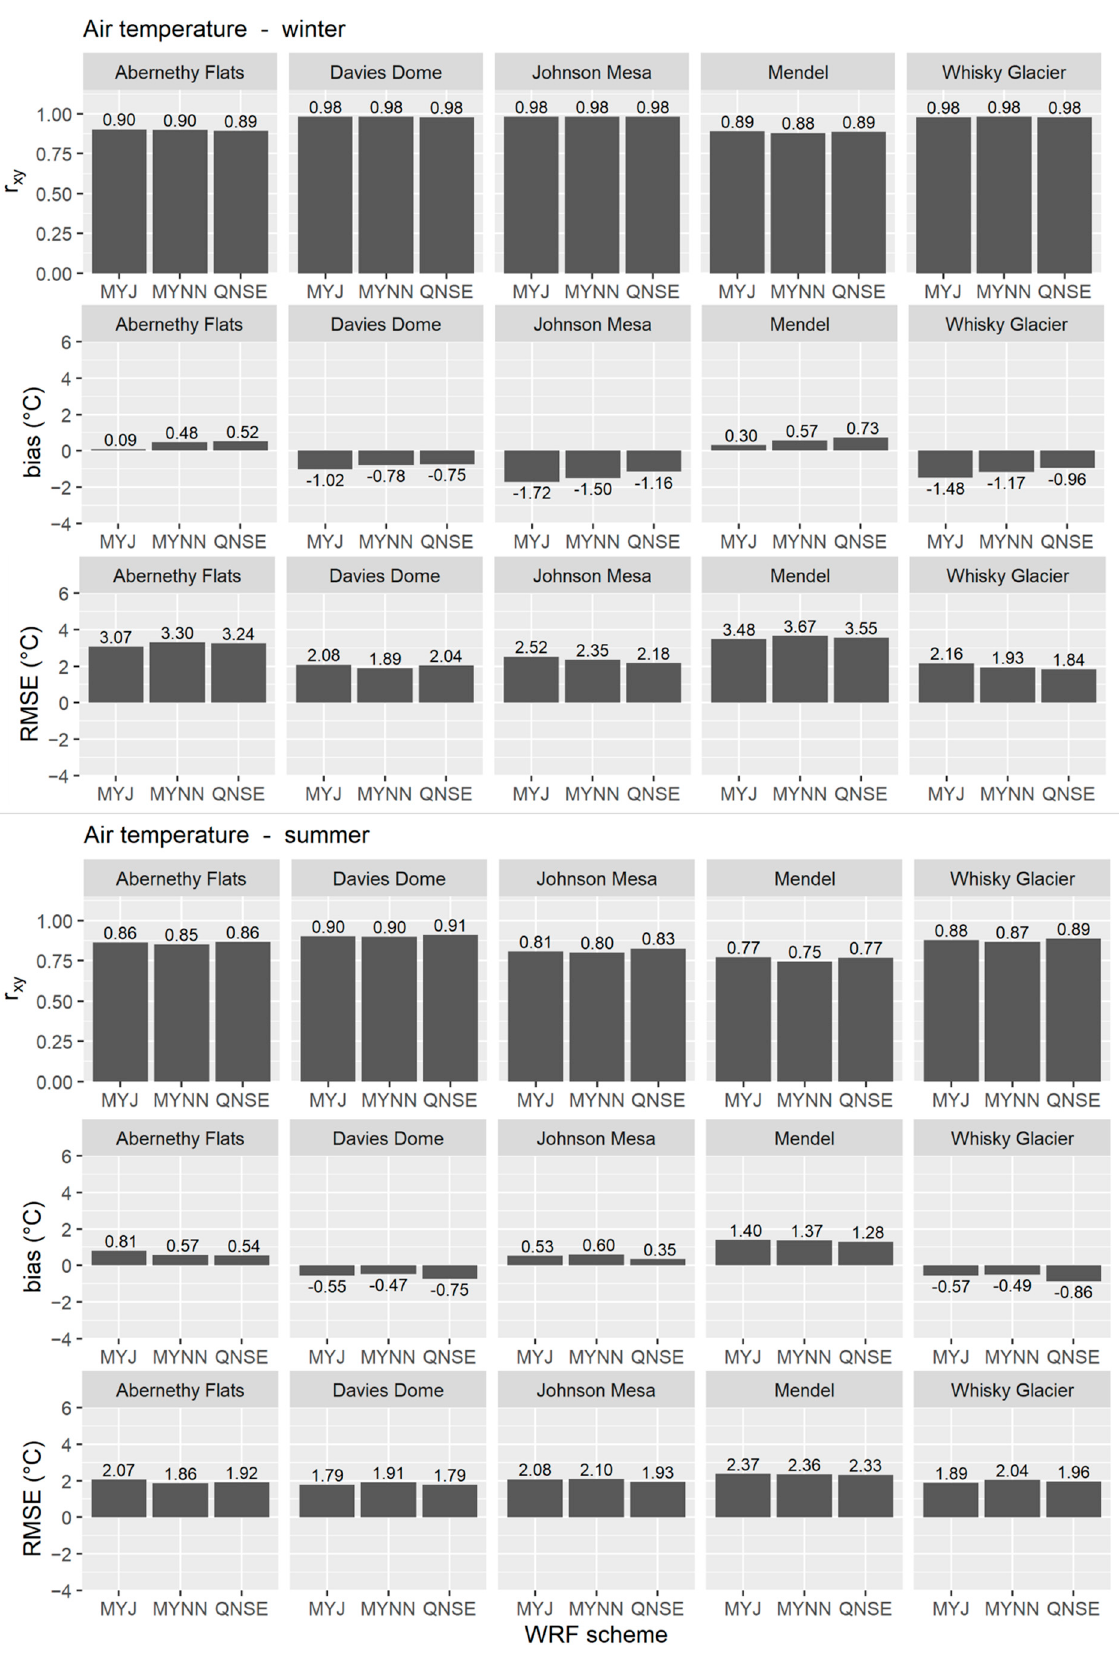
Figure 4. Validation statistics for modelled air temperature at selected automatic weather stations using three boundary layer schemes (MYJ, MYNN, QNSE) during the winter and summer periods.